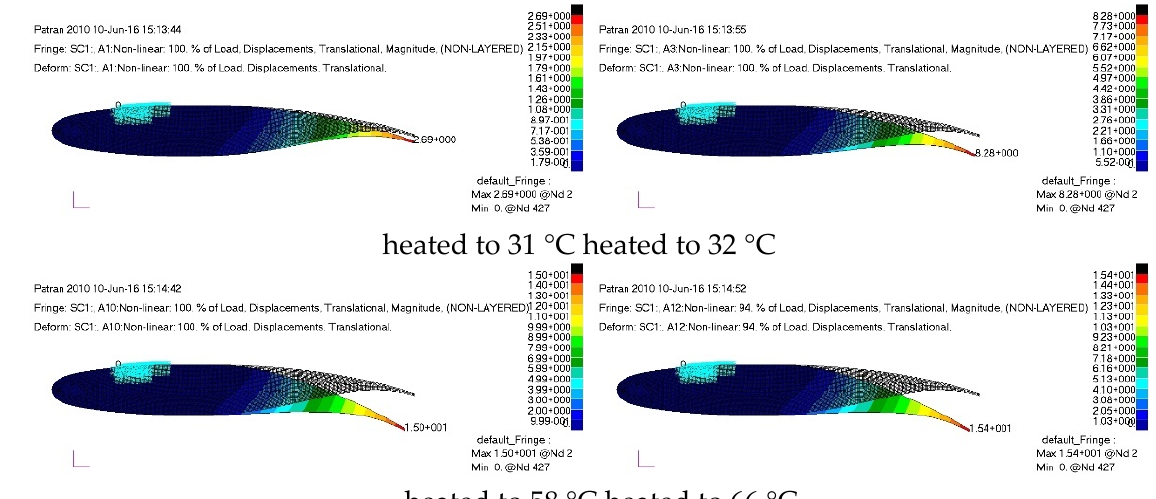
Actuators 2021 , 10 , x FOR PEER REVIEW Figure 8. Analysis of finite element on trailing edge deflection displacement. Figure 8. Analysis of finite element on trailing edge deflection displacement.